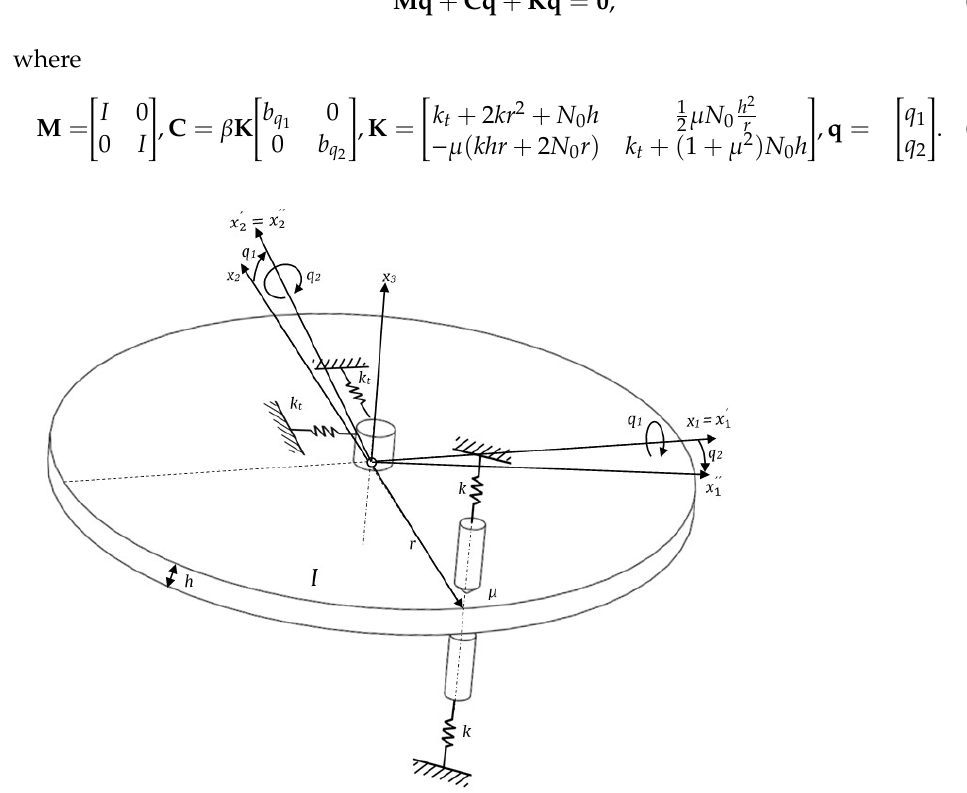
Figure 1. Minimal model of rigid disc brake including friction force between the pads and a wobbling